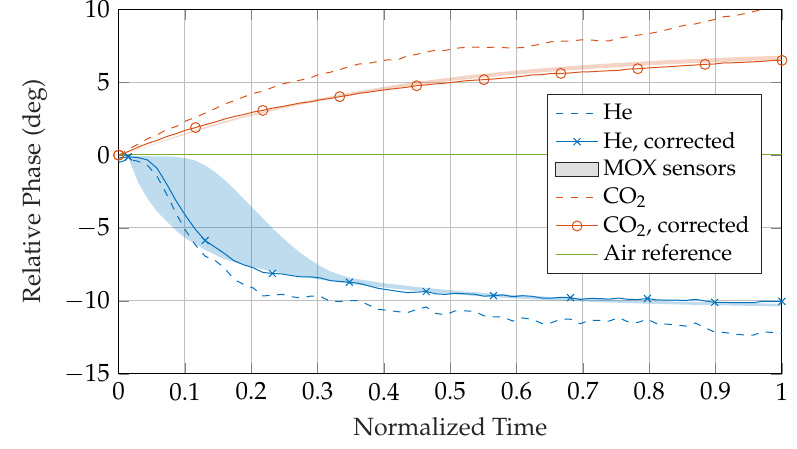
Figure 7. Phase difference of He and CO 2 to the air reference evaluated at ∆ f 12 during the filling process. Data was acquired in a transmission measurement with two opposing synchronized radar sensors. Minimum and maximum boundaries are derived from MOX gas concentration results. After compensation of time-variant setup deviation is applied the differential-mode component shows good agreement to the minimum and maximum